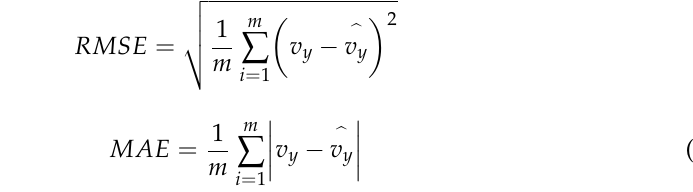
Figure 8. Estimation Results under 70 km/h DLC condition: ( a ) road friction coefficient of 0.3; ( b ) road friction coefficient of 0.5; ( c ) road friction coefficient of 0.85; ( d ) road friction coefficient of 1.0.